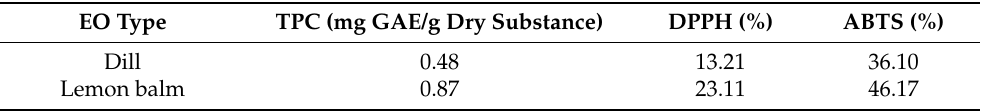
Table 1. Total phenolic content (TPC) and antioxidant characteristics evaluated for dill EO and lemon balm EO at a concentration of 60 mg mL − 1 in